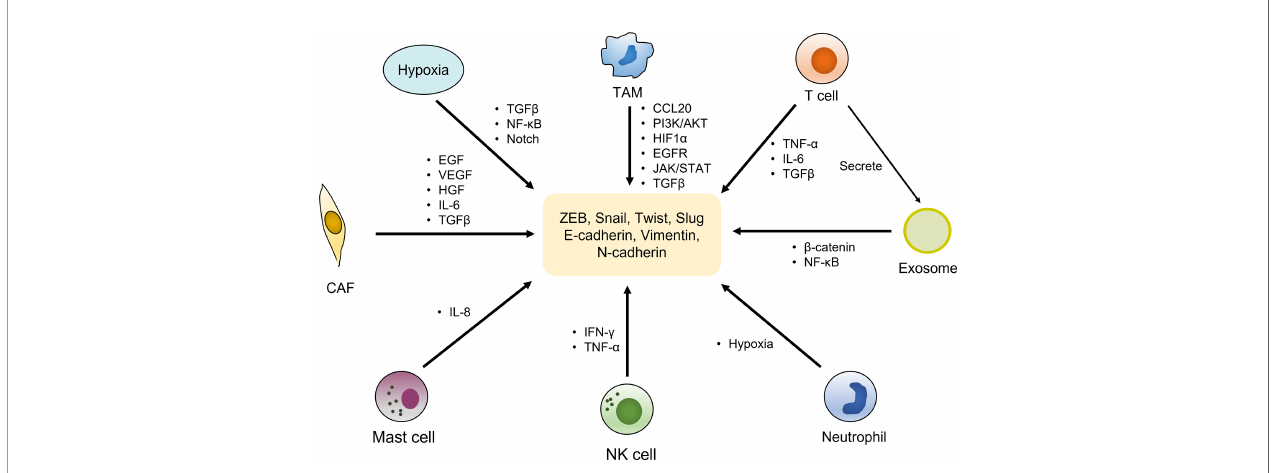
FIGURE 2 | EMT activation by components of the tumor microenvironment. The tumor microenvironment is composed of cellular and non-cellular components. The cellular components mainly include immune cells (T cells, TAMs, neutrophil, NK cells, mast cells, etc.), cancer-associated fi broblasts (CAFs) and other types of cells, which activate the expression of various EMT transcriptional factors and markers by secreting cytokines and growth factors as well as regulating multiple signaling pathways, to induce EMT phenotype. Hypoxia environment as a non-cellular factor also exerts vital roles in trigger EMT by activating relevant